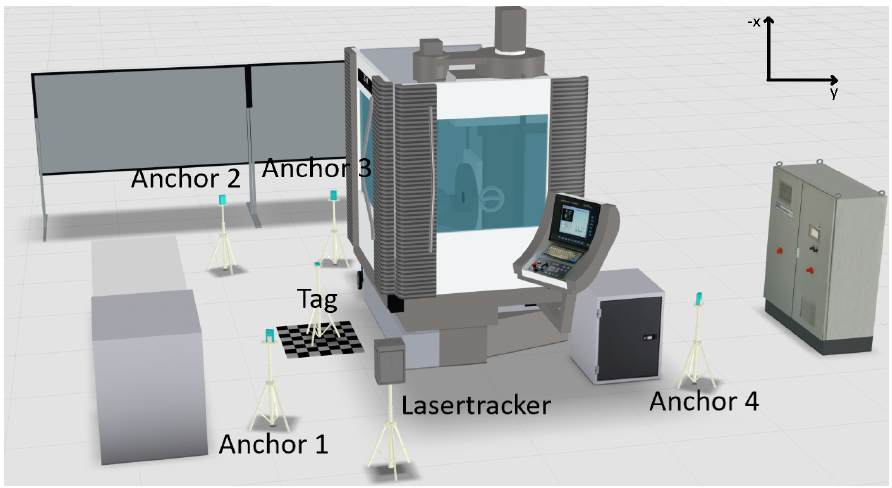
Figure 6. Visualization scenario 2: Three lines of